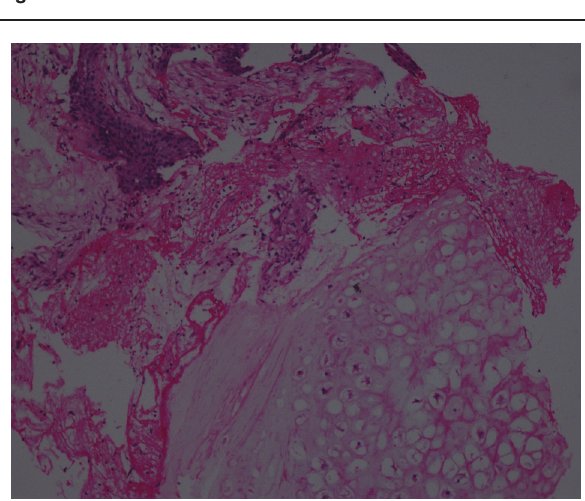
Histopathology image of the bronchial biopsy specimen.